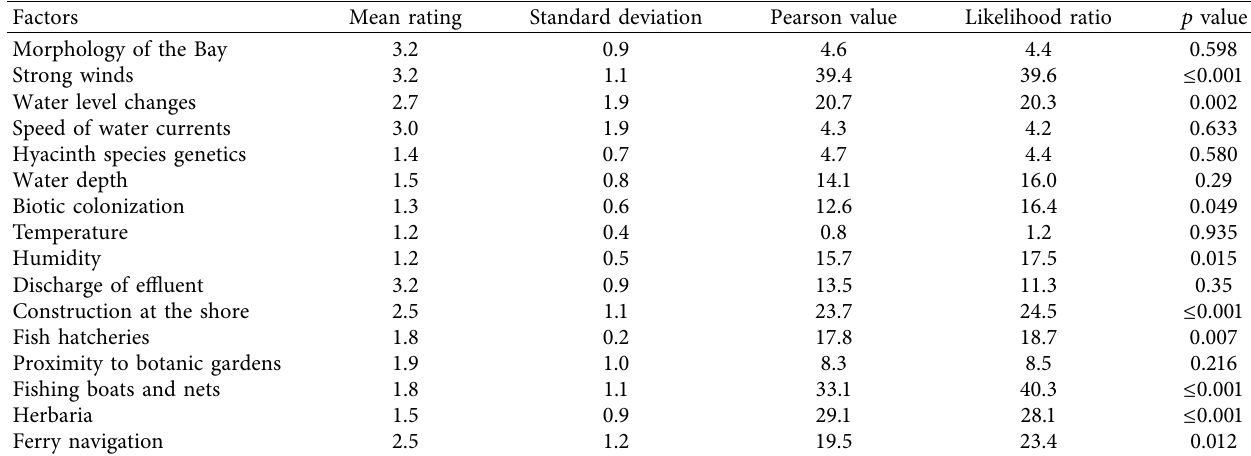
Table 3: Mean rating, standard deviation, and Pearson’s chi-square results showing the relationship between the water hyacinth de- terminants and landing